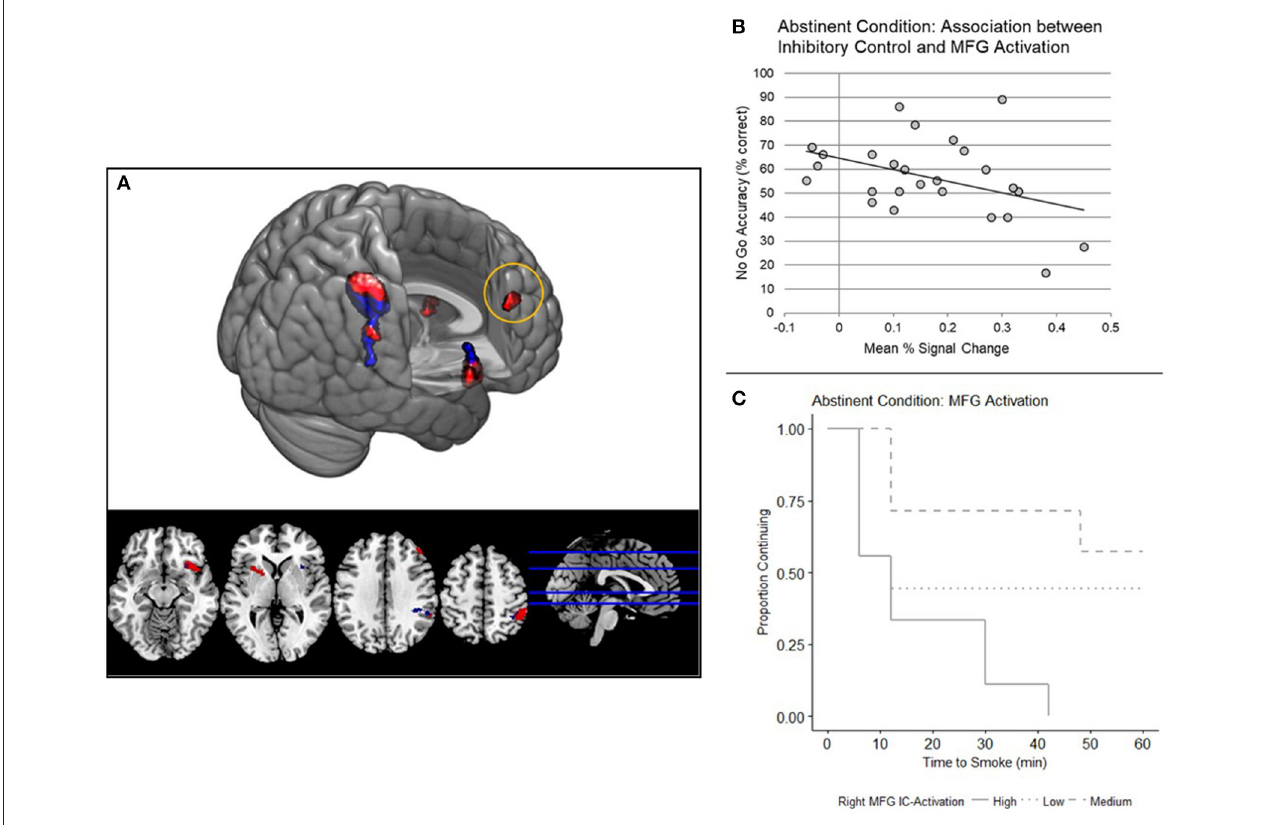
FIGURE 3 | (A) Whole brain analyses: main effect of inhibitory control (IC) task. Main effect of trial type (No Go Correct, Rare Go Correct) across the whole brain, examined independently in a one-way ANOVA under each condition (red, Abstinent; blue, Sated; N = 26, p < 0.05 FWE corrected). (B) Right middle frontal gyrus (MFG) IC-Activation and No Go Accuracy. IC-Activation (Mean PSC) in right MFG is negatively correlated with No Go accuracy ( N = 26, p = 0.040). Mean percent signal change is from the No Go Correct - Rare Go Correct contrast. (C) Right MFG IC-Activation and smoking relapse analog task (SRT) Performance. Survival curves were stratified by high, medium, and low MFG IC-Activation for illustrative purposes. A Cox regression model indicated that right MFG IC-Activation predicts time to smoke during the SRT ( N = 25, p =